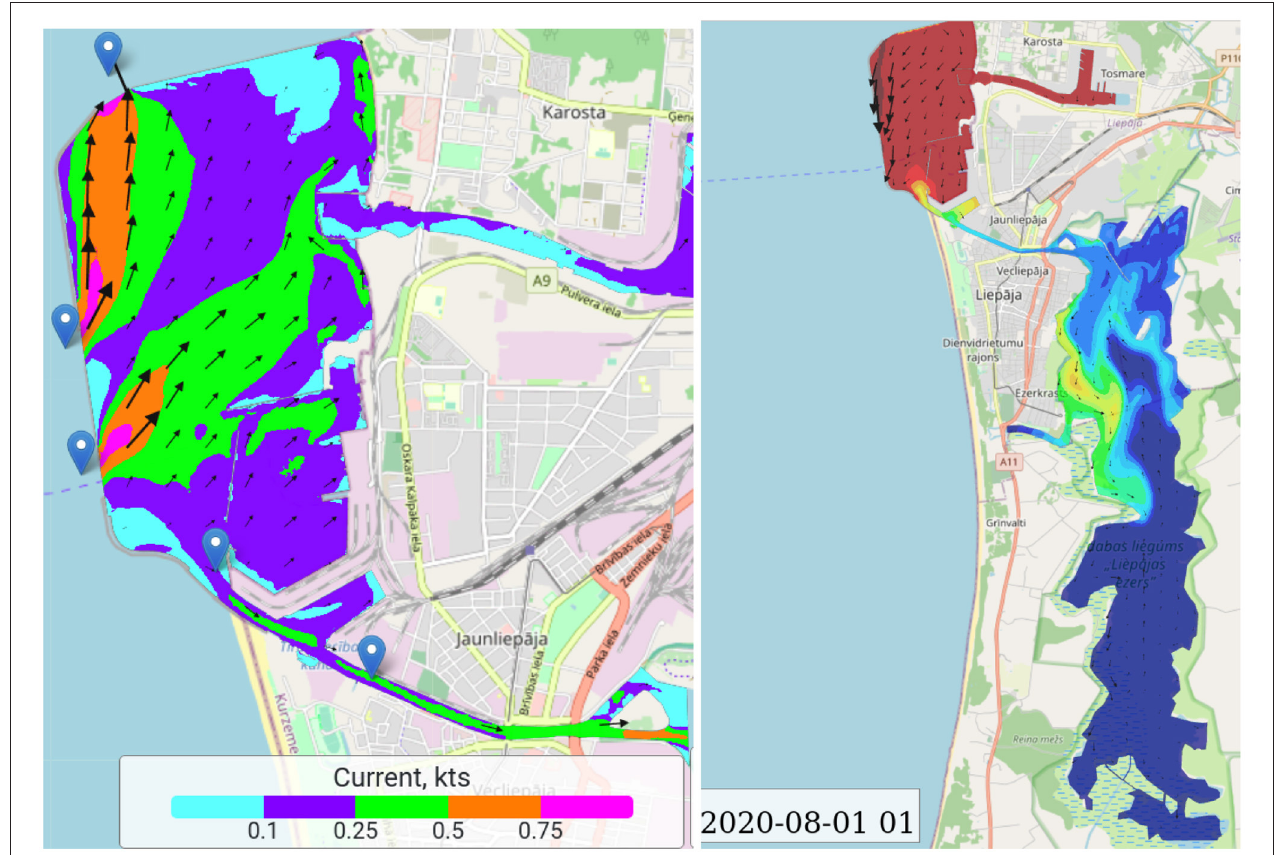
FIGURE 3 | (Left) Surface flow rate at 2020.12.30 00:00 showing transit flow through the Central and North gates. (Right) Salinity distribution after the period of low river run-off and precipitation at